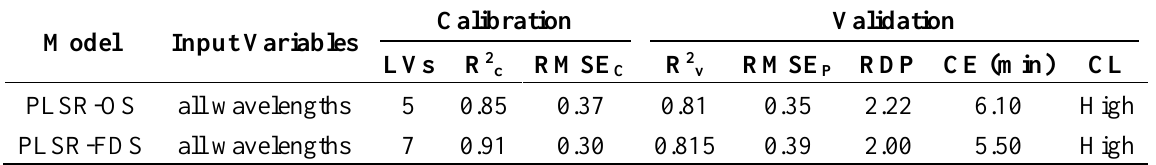
Table 6. The best-performing LNC models based on partial least-squares regression (PLSR) for the calibration and validation sets.